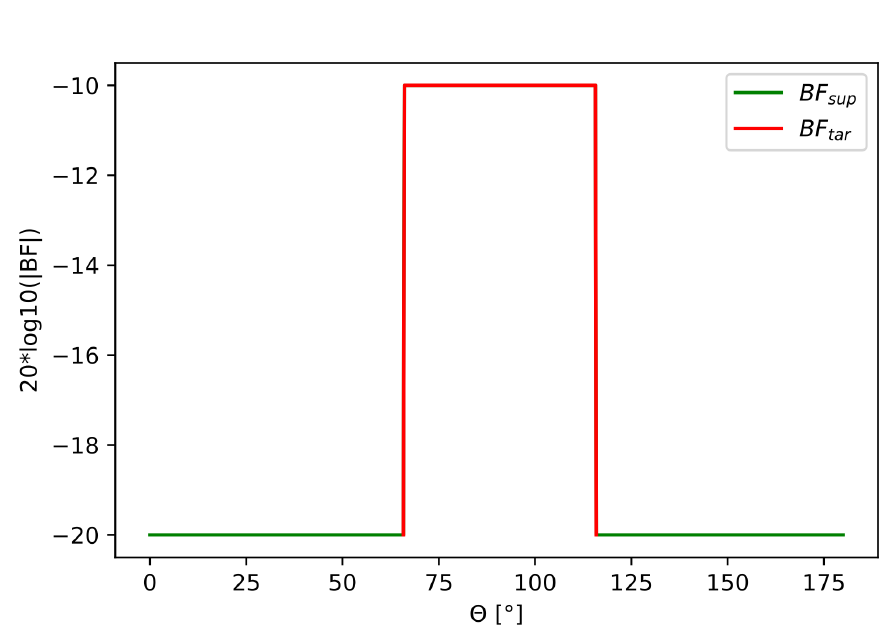
Figure 2. Beampattern mask including BF tar in red and BF sup in